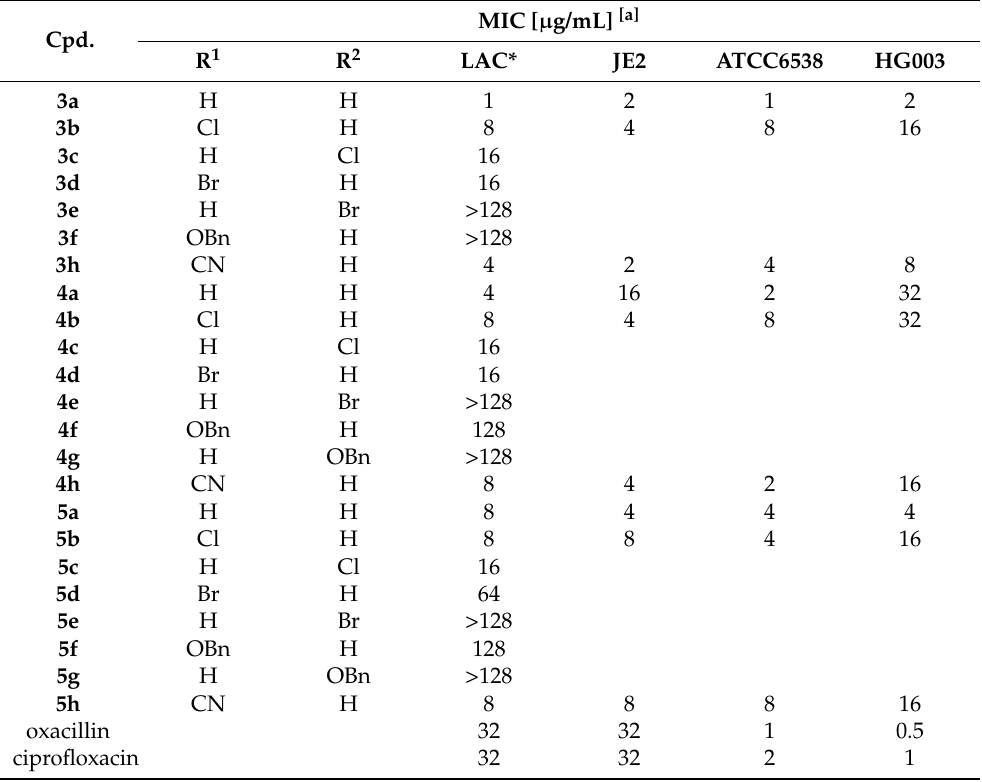
Table 1. Antibacterial activity data of target compounds 3a – f , h , 4a – h and 5a – h with varied substitu- tion patterns expressed as MIC values.